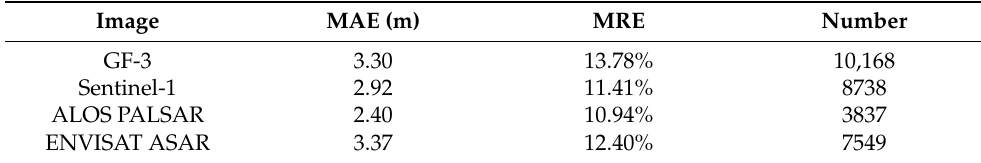
Table 4. Errors of valid